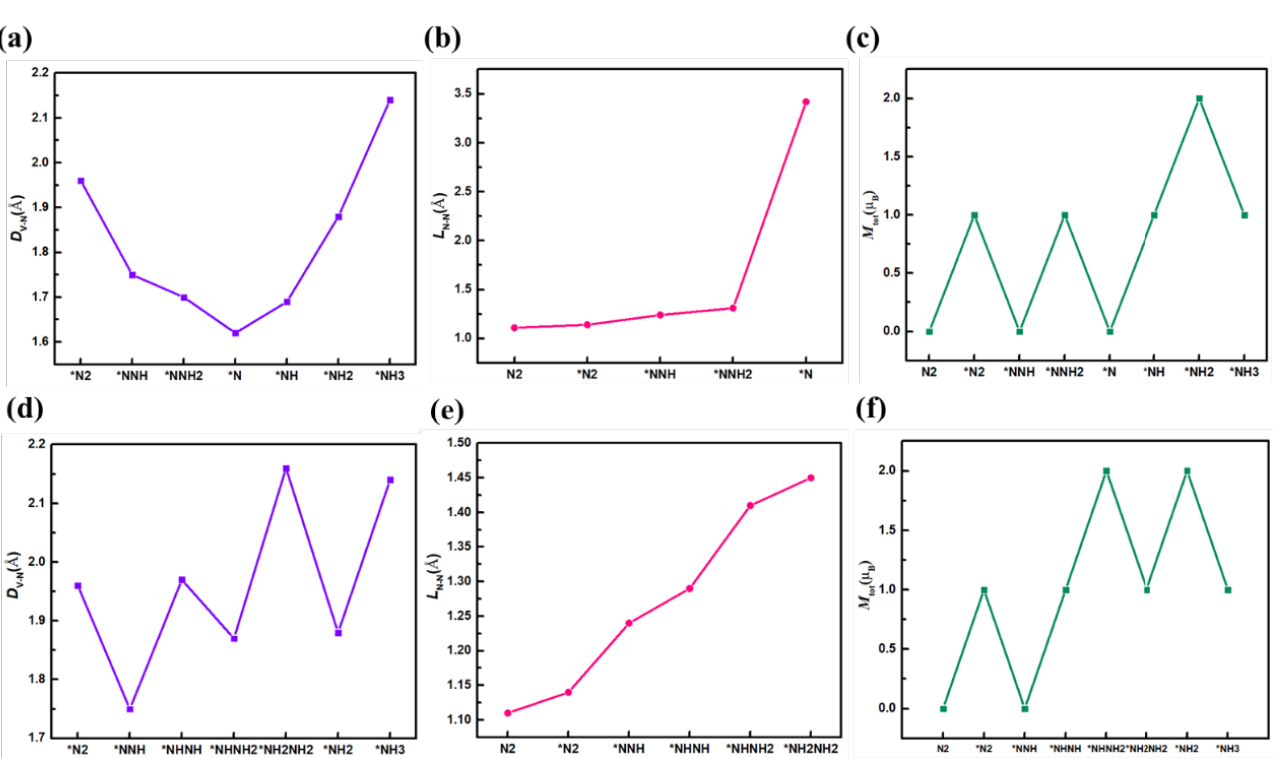
Figure 8. D V-N , L N-N and total magnetic moment ( M tot ) of adsorbates on V@g-C 3 N 4 via an ( a – c ) distal mechanism and ( d – f ) alternating mechanism.